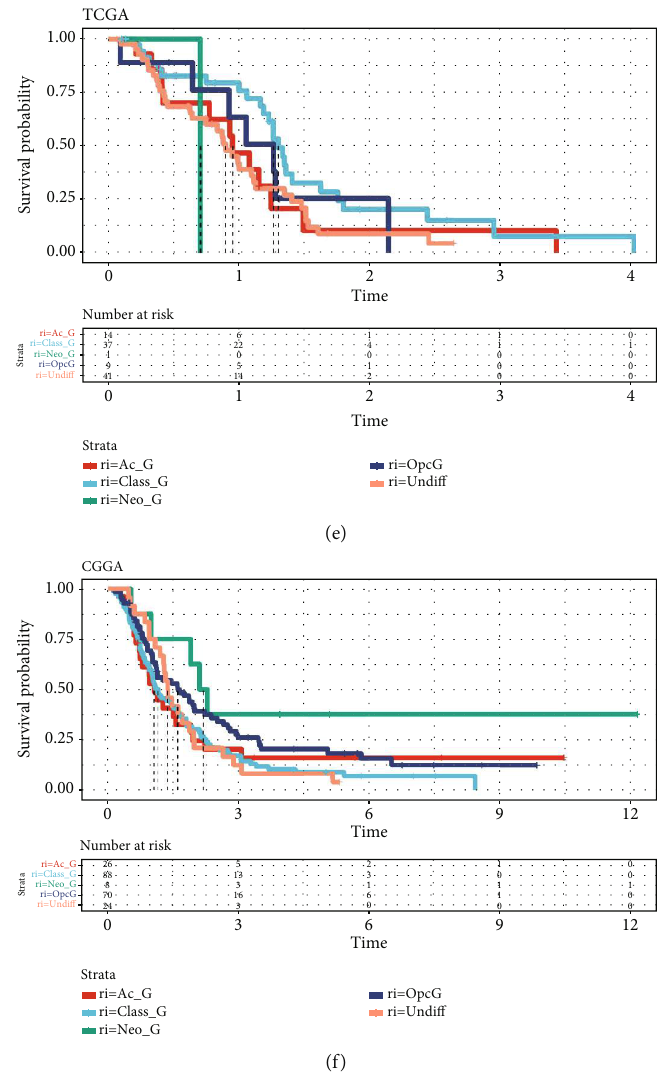
Figure 5: Classi fi cation of GBM samples from TCGA and CGGA datasets based on the expression pro fi les of the fi ve clusters of malignant cells. (a) Venn diagram showing the similarities and di ff erences of the calculated markers of Ac-G/Class-G/Neo-G/Opc-G/Undi ff -G clusters. (b) Heatmap showing the expressions of the selected 64 marker genes of Ac-G/Class-G/Neo-G/Opc-G/Undi ff -G in all 13 clusters. (c, d) Heatmap showing the abundance of the 5 clusters in the fi ve clustered groups of TCGA and CGGA samples. (e, f) The Kaplan-Meier curves of OS for the fi ve clustered groups of TCGA and CGGA